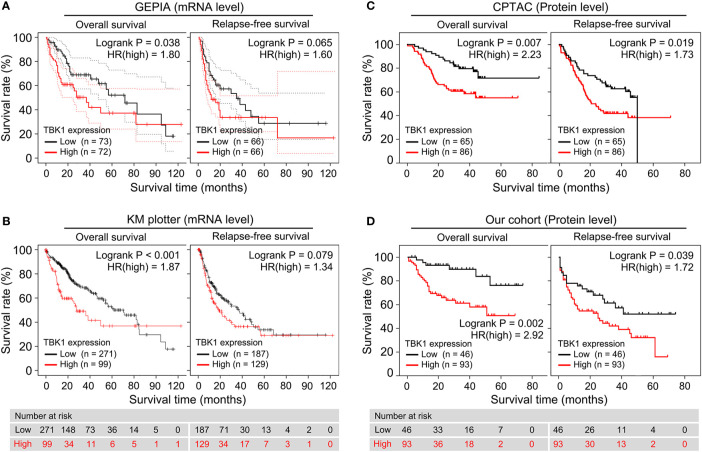
High TANK-binding kinase 1 (TBK1) expression predicted poor prognosis in patients with hepatocellular carcinoma (HCC). (A, B) Gene Expression Profiling Interactive Analysis (GEPIA) and the Kaplan–Meier (KM) plotter were used to construct the survival curves of overall survival (OS) and relapse-free survival (RFS) based on the TBK1 mRNA expression in patients with HCC. (C, D) The KM survival curves based on TBK1 protein expression in patients with hepatocellular carcinoma (HCC) were determined using Clinical Proteomic Tumor Analysis Consortium (CPTAC) database and our cohort.